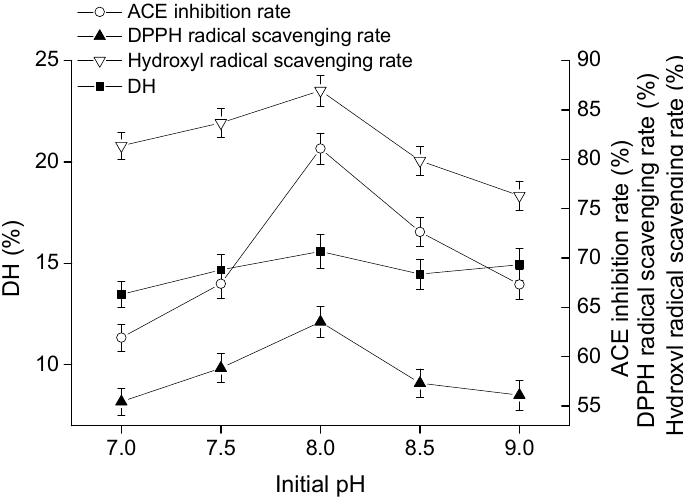
Figure 4. Effect of initial pH on DH, ACE inhibitory activity, and antioxidant activity of hydrolysate at time of 4 h, temperature of 41 °C, and E / S of 10% ( w / w ). The error bars represent standard deviation of means ( n = 3).